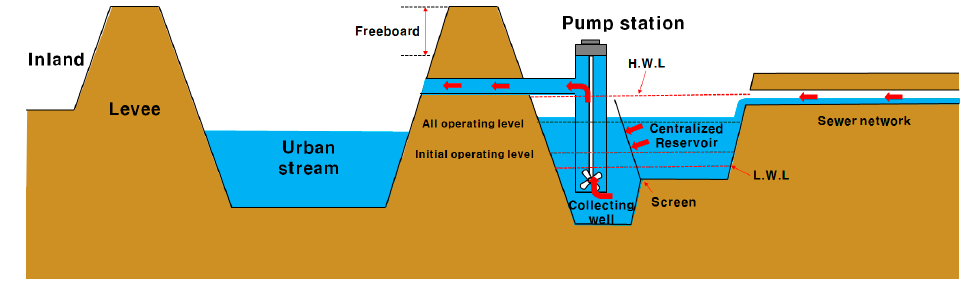
Figure 3. Structure of a typical pump station with a centralized reservoir.